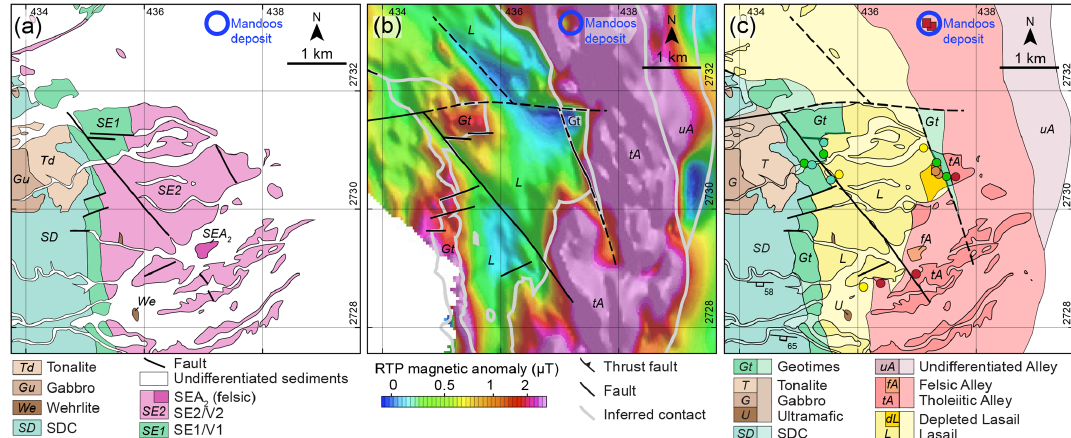
Figure 15. Mapping example: part of a Lasail basaltic accumulation in the northern Fizh block near the Tholeiitic Alley-hosted Mandoos VMS deposit (Gilgen et al., 2014). (a) Distribution of volcanic units according to the pre-existing regional geological map (BRGM, 1993b). (b) RTP aeromagnetic survey (Isles and Witham, 1993) with inferred bedrock contacts and faults (this study). (c) Revised map (this study) with sample location symbols as in Fig. 11. Coordinate grid: UTM 40 N in